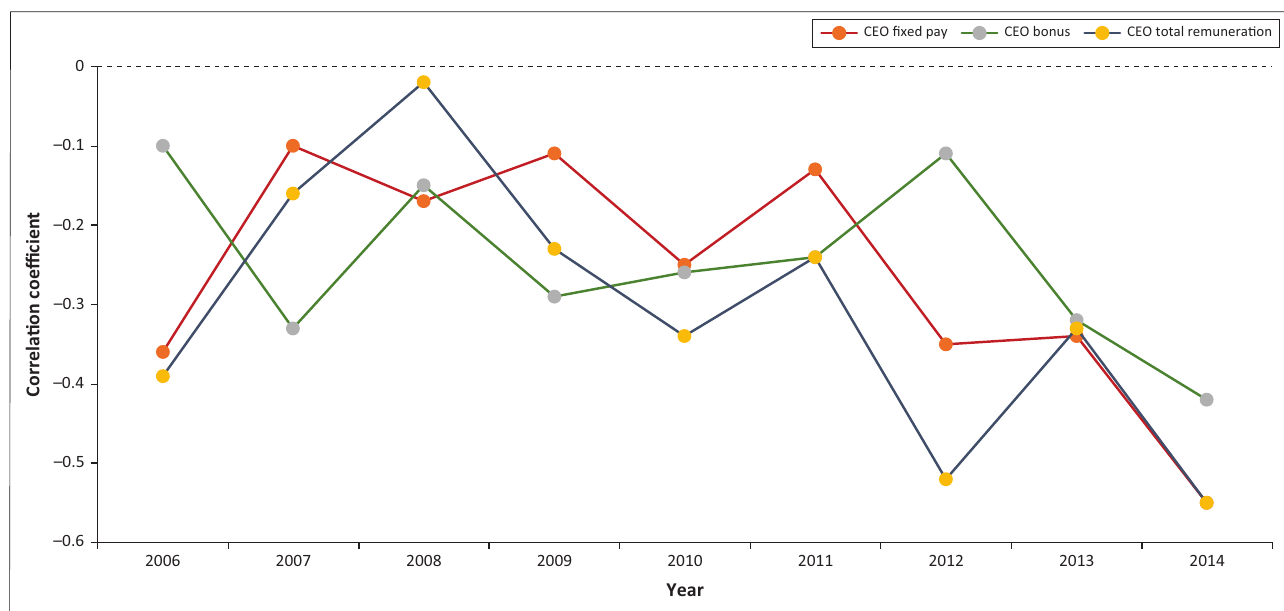
FIGURE 4: Audit opinion and state-owned companies’ performance. CEO, chief executive